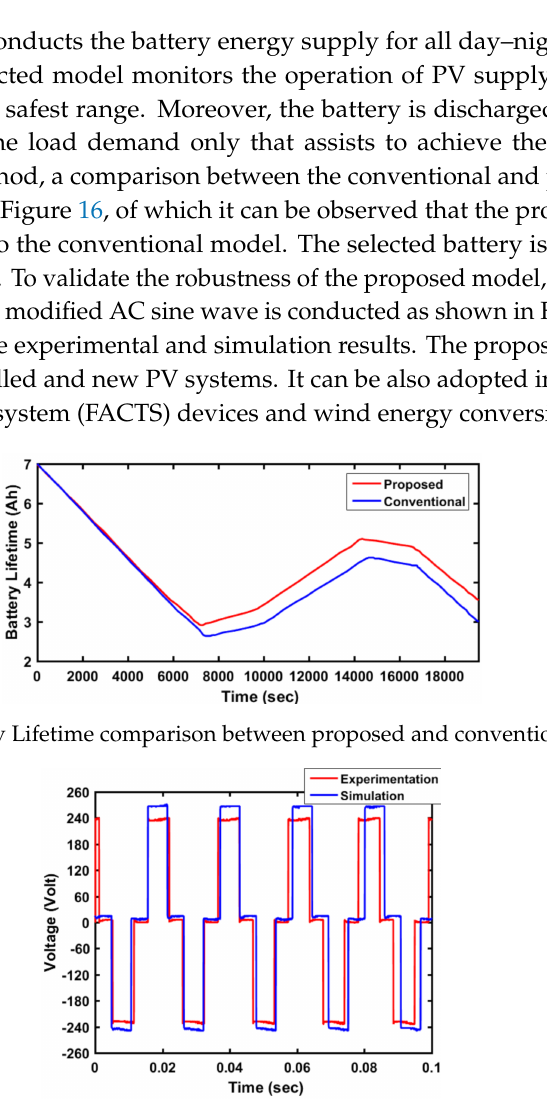
Figure 17. Comparison between simulation and experimentation Modified AC